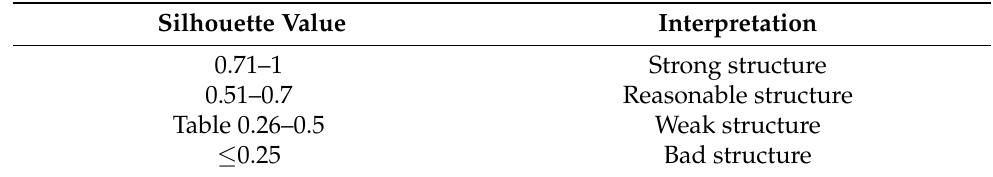
Table 1. Overview of average silhouette value